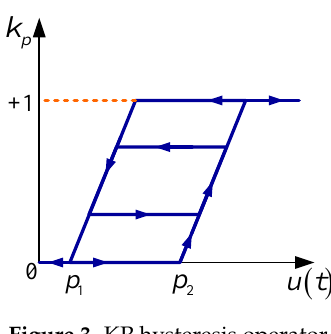
Figure 3. KP hysteresis